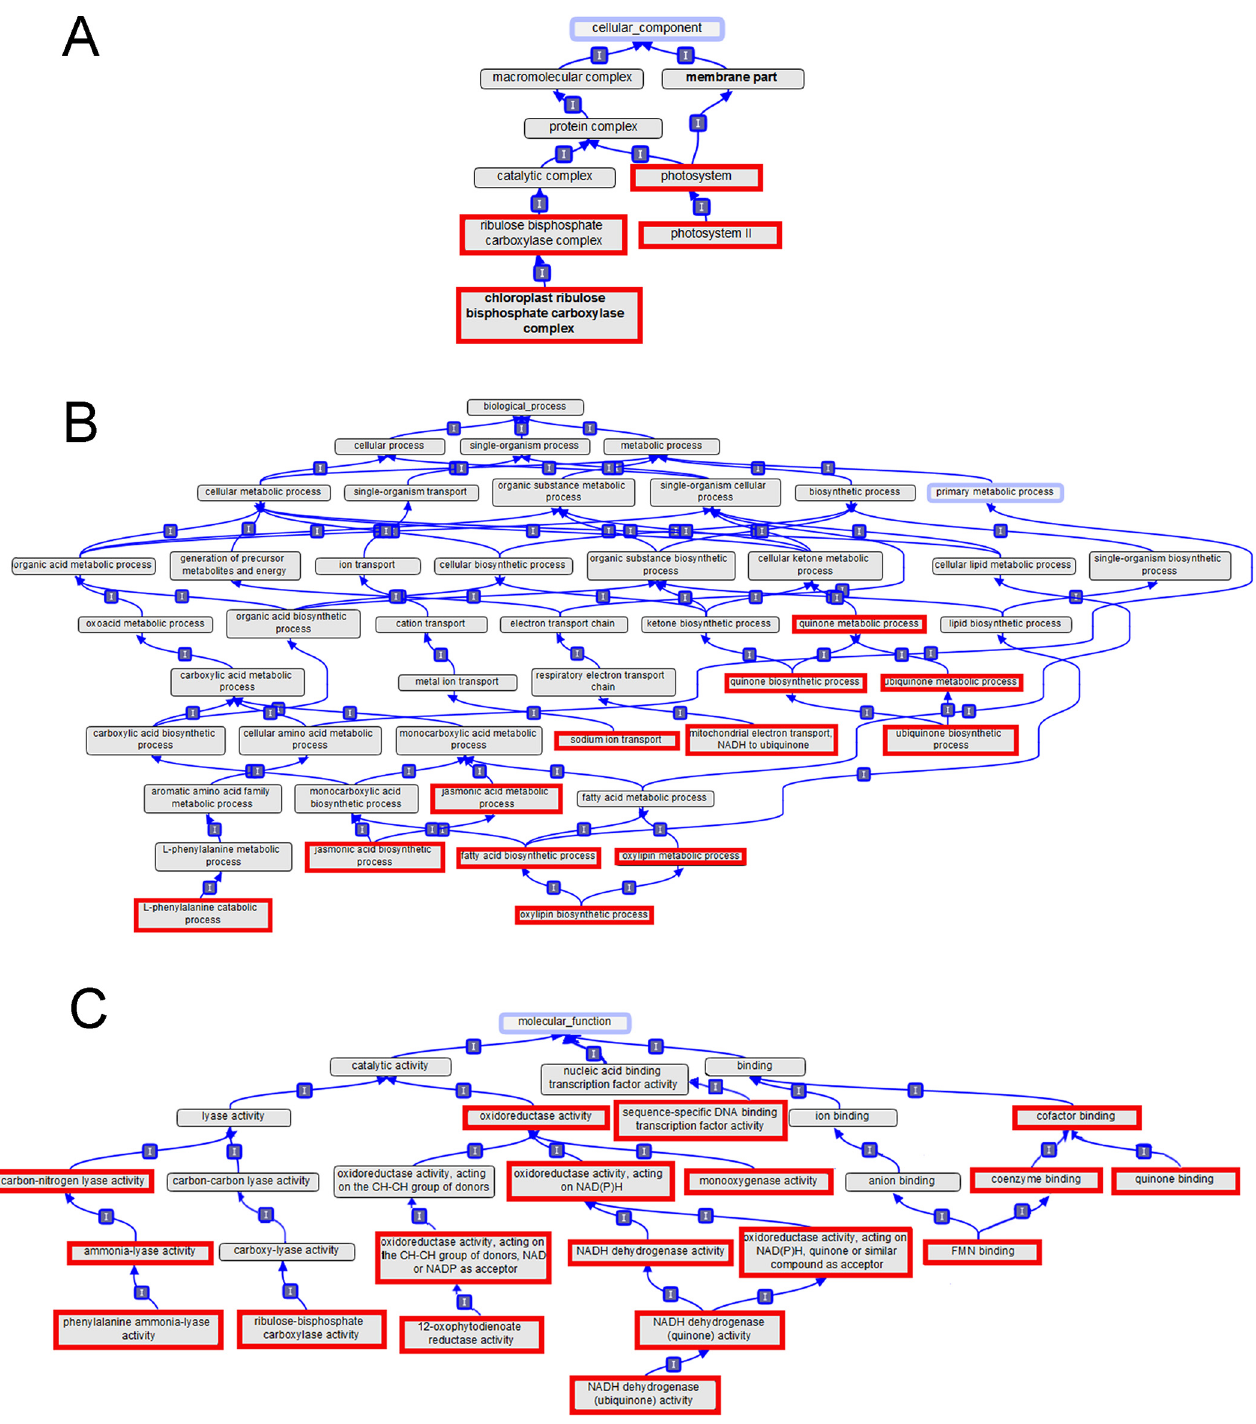
Fig 2. Gene ontology diagrams showing the 34 GO terms significantly responding to freeze-thaw in wheat crowns. Plants were: frozen to − 3°C for 24 h; frozen to − 3°C for 24 h then allowed to thaw at +3°C for 24 h; frozen to − 3°C for 24 h then allowed to thaw at +3°C for 48 h. The GO terms outlined with red were significantly over-represented in common after each of the three temperature treatments. Terms are shown from three GO domains ( A: cellular component, B: biological process, and C: molecular function).